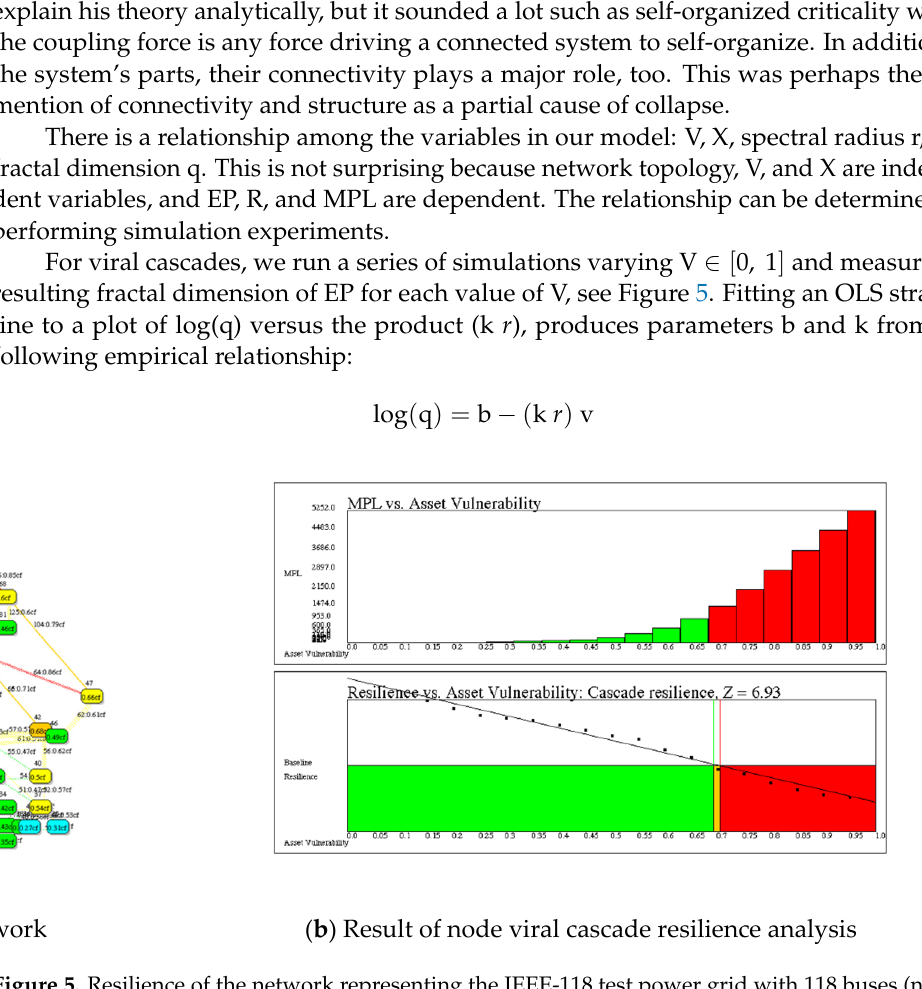
Figure 5. Resilience of the network representing the IEEE-118 test power grid with 118 buses (nodes) and 180 power lines (links) [12]. ( a ) Network with the frequency of cascading cF shown as a colored heat map and numerical values. ( b ) Upper graph shows MPL risk for each value of vulnerability from 0 to 1.0; Lower graph shows resilience declining with respect to v; and the line crossing at log(q) = 0 yields resilience, Z = 6.93 when q = 1.0.